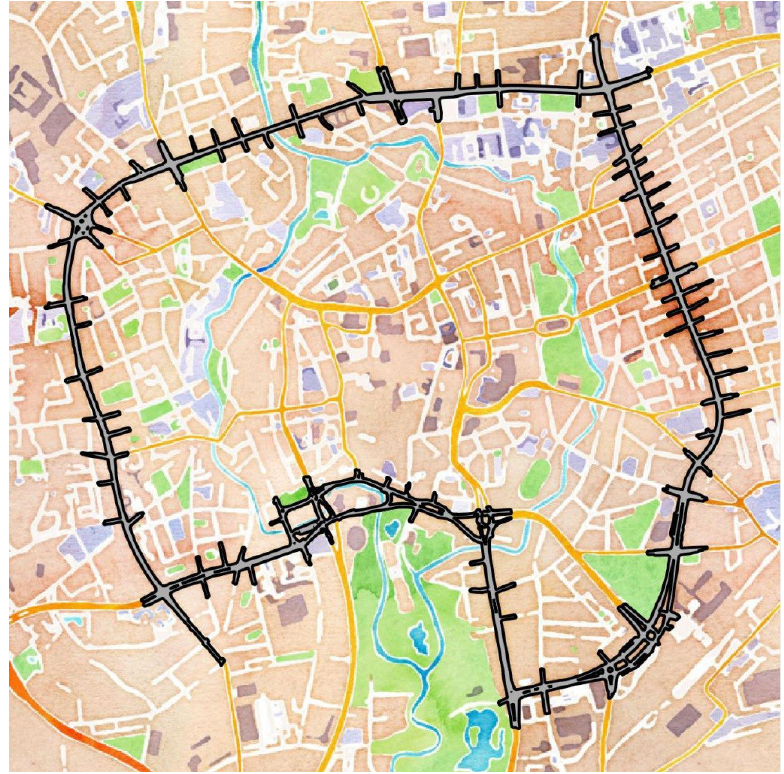
Figure 1: Braunschweig‘s city ring (grey) as overlay on